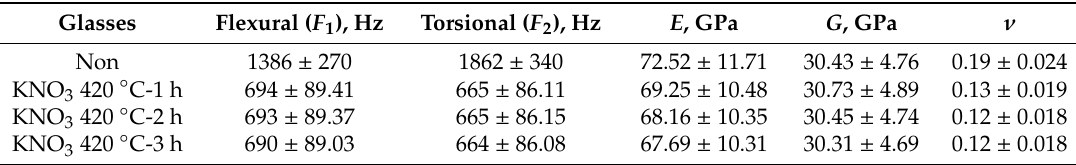
Table 6. Results obtained by IET